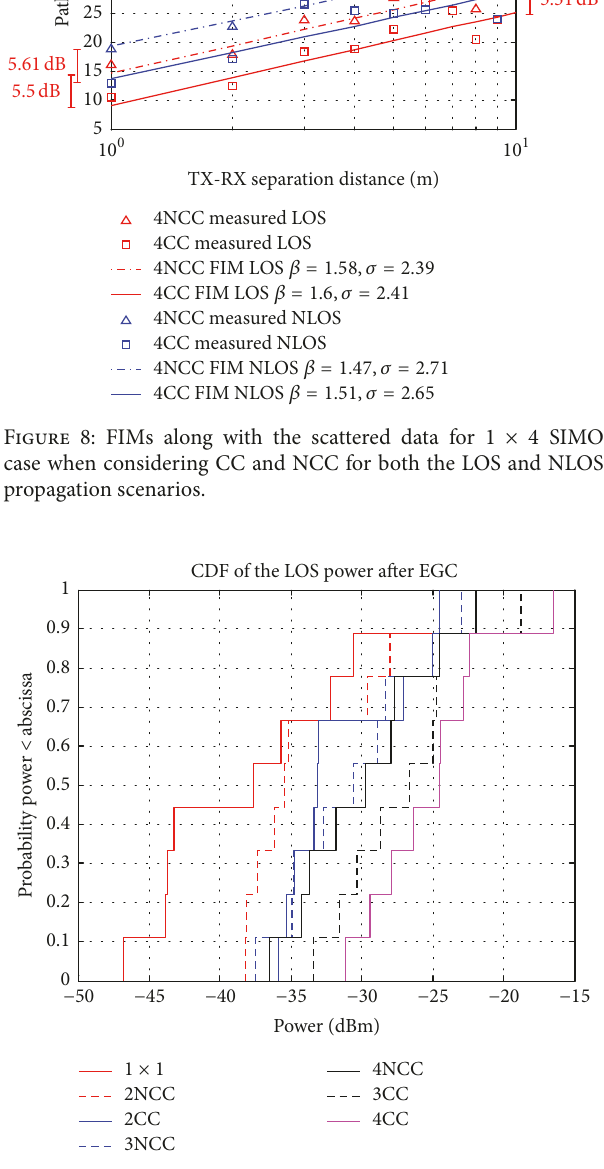
Figure 9: CDF of receiver spatial diversity after applying CC and NCC schemes for the LOS